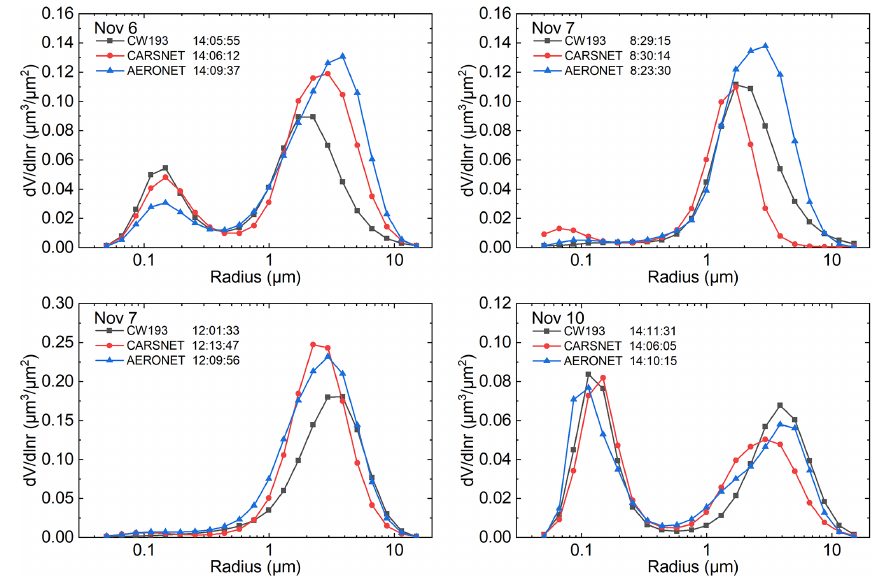
Figure 9. Comparison of retrieved VSDs from CW193, CARSNET and AERONET for four selected